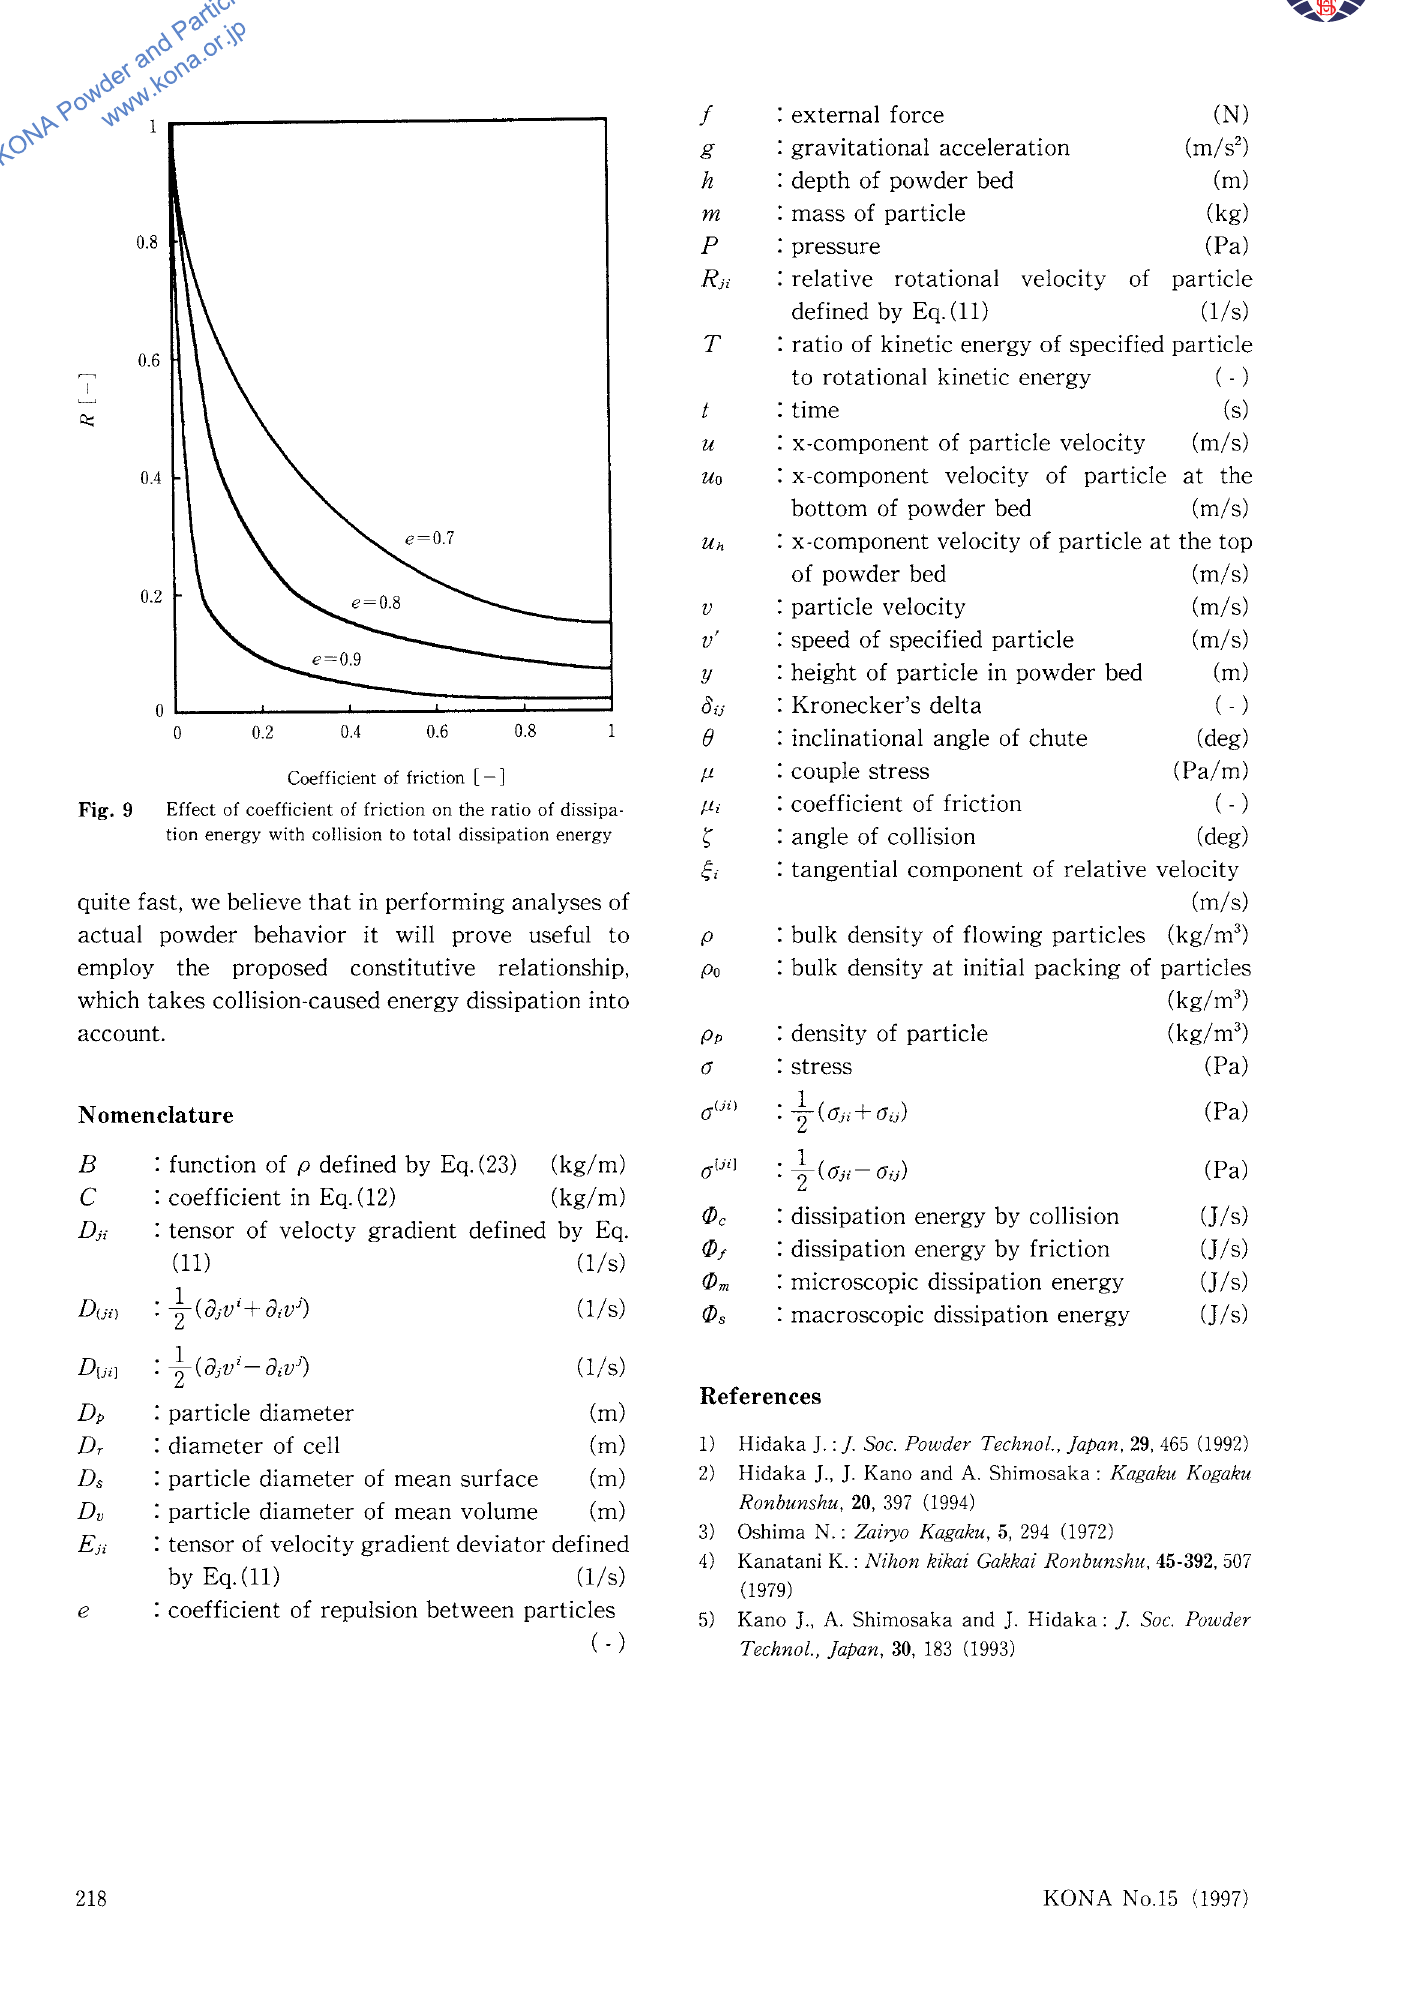
Coefficient of friction [-] Fig. 9 Effect of coefficient of friction on the ratio of dissipa· tion energy with collision to total dissipation